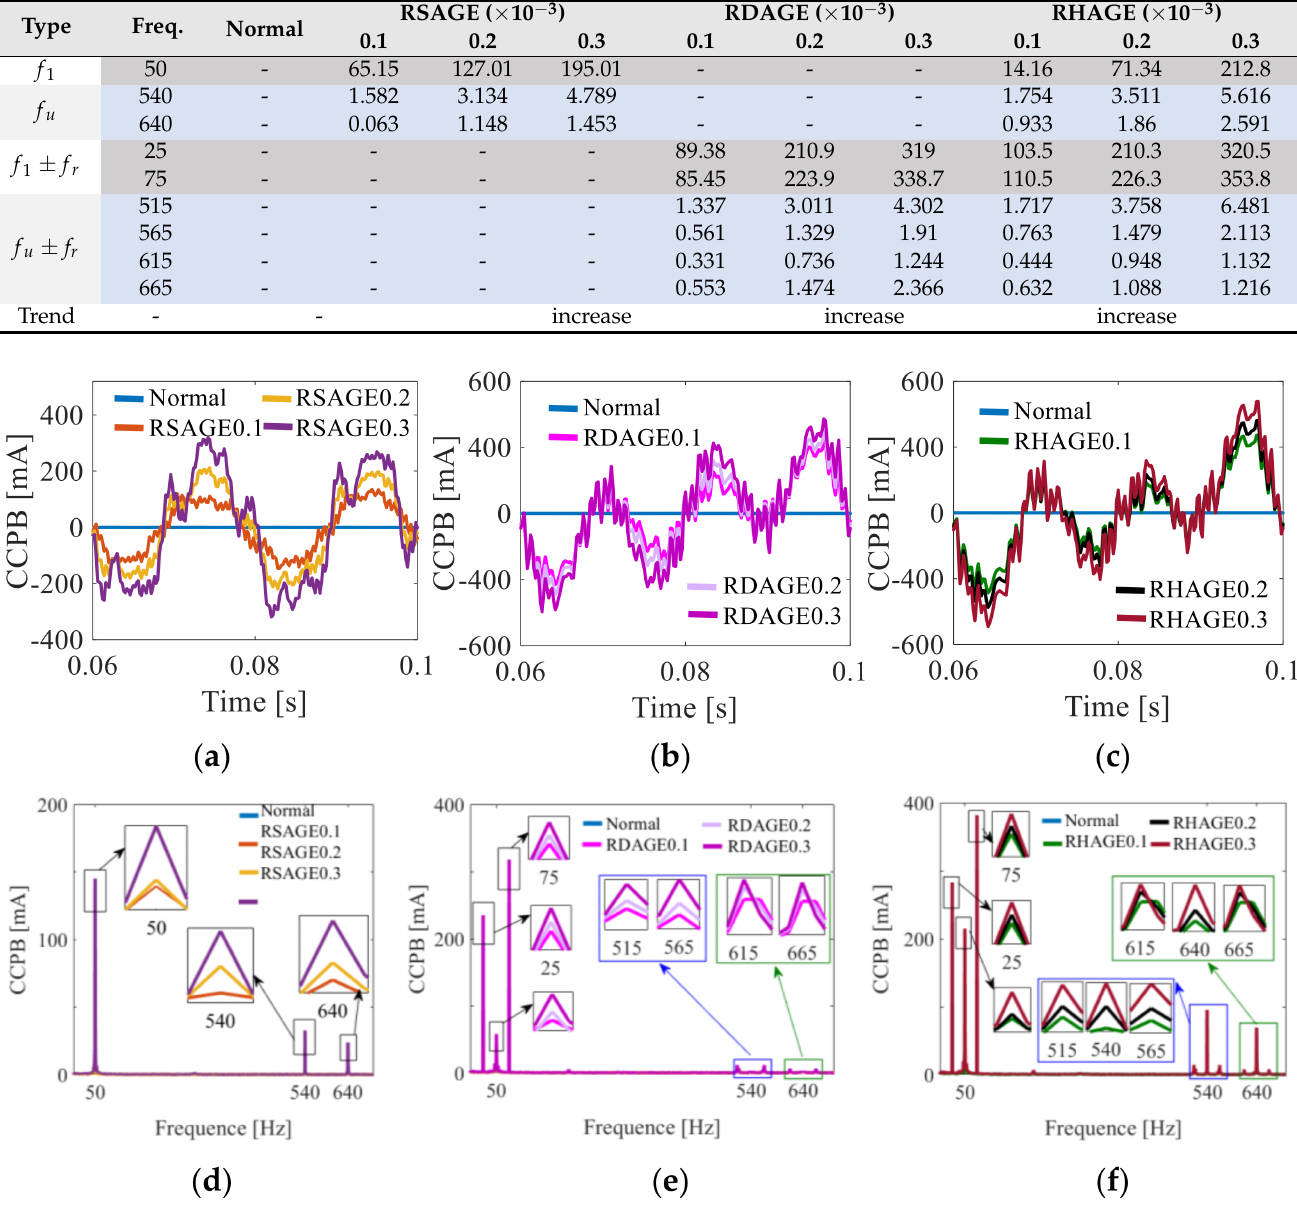
Table 6. Simulation results of CCPB.